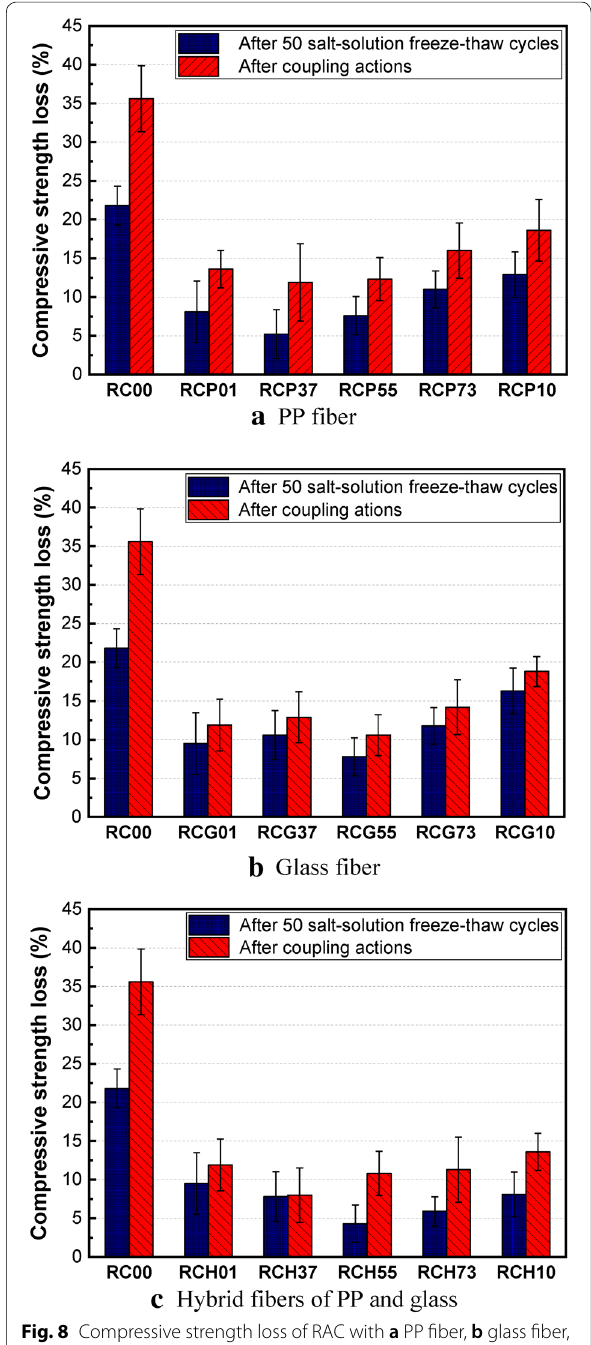
Fig. 8 Compressive strength loss of RAC with a PP fiber, b glass fiber, and c hybrid fiber after 50 salt solution freeze–thaw cycles and the coupled action of mechanical loading and salt solution freeze–thaw